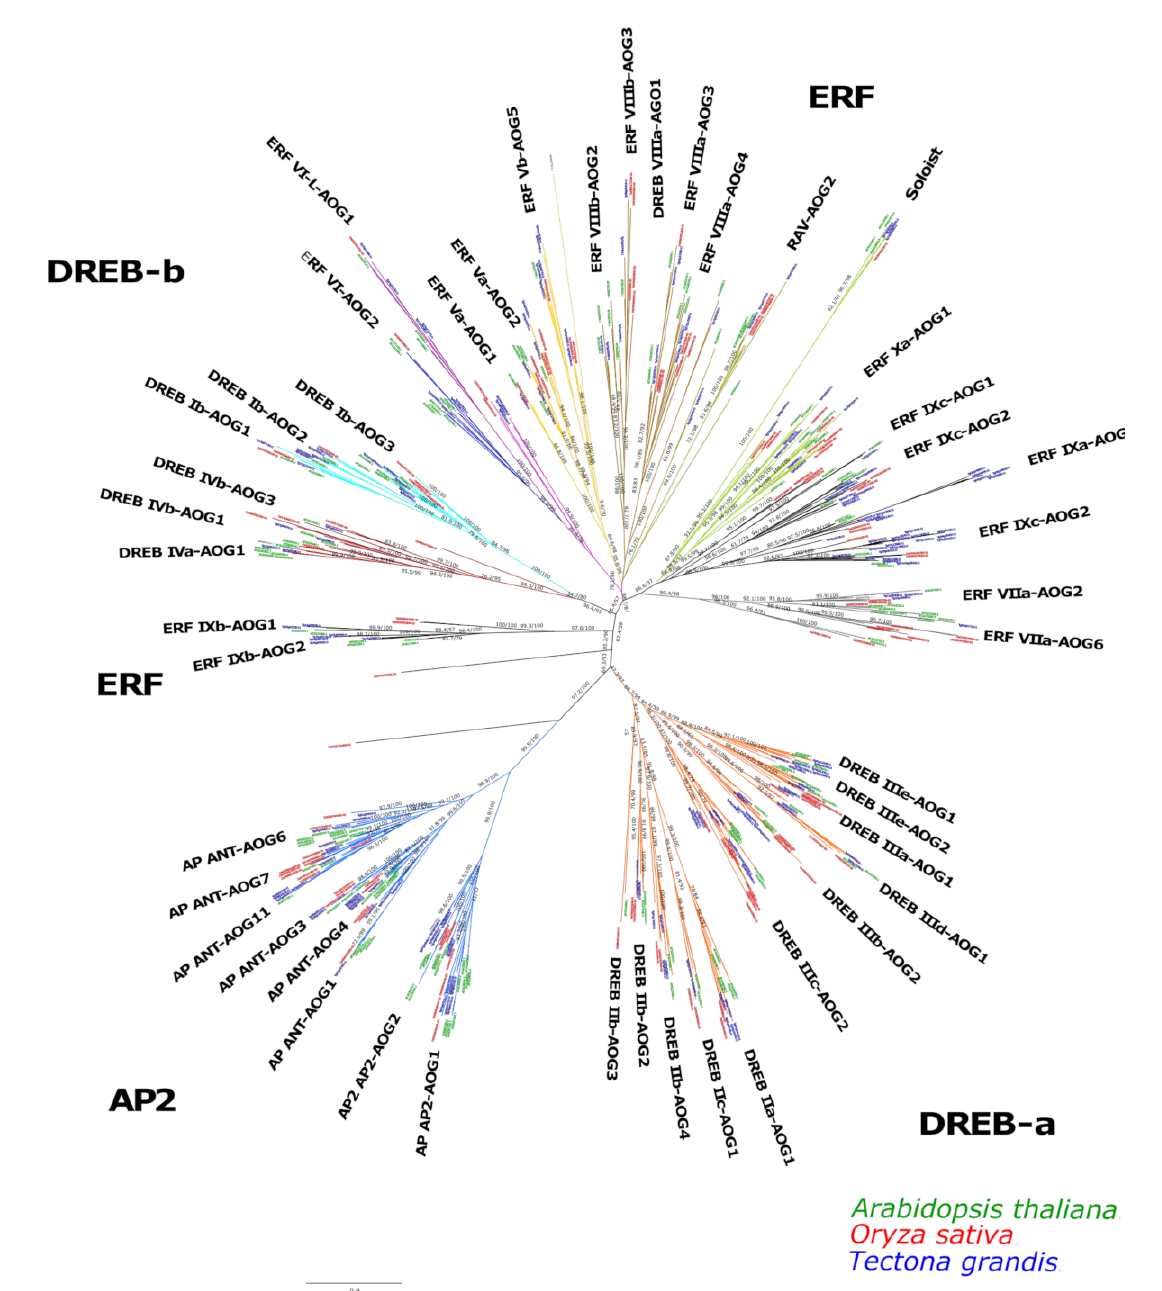
Figure 1. Phylogenetic tree for the AP2/ERF family transcription factors of teak, Arabidopsis, and rice. The transcription factors of teak are shown in blue, Arabidopsis in green, and rice in red. A consensus tree is shown. Subgroups’ names were classified according to Wang (2019) [32]. The scale bar indicates the substitution rate per